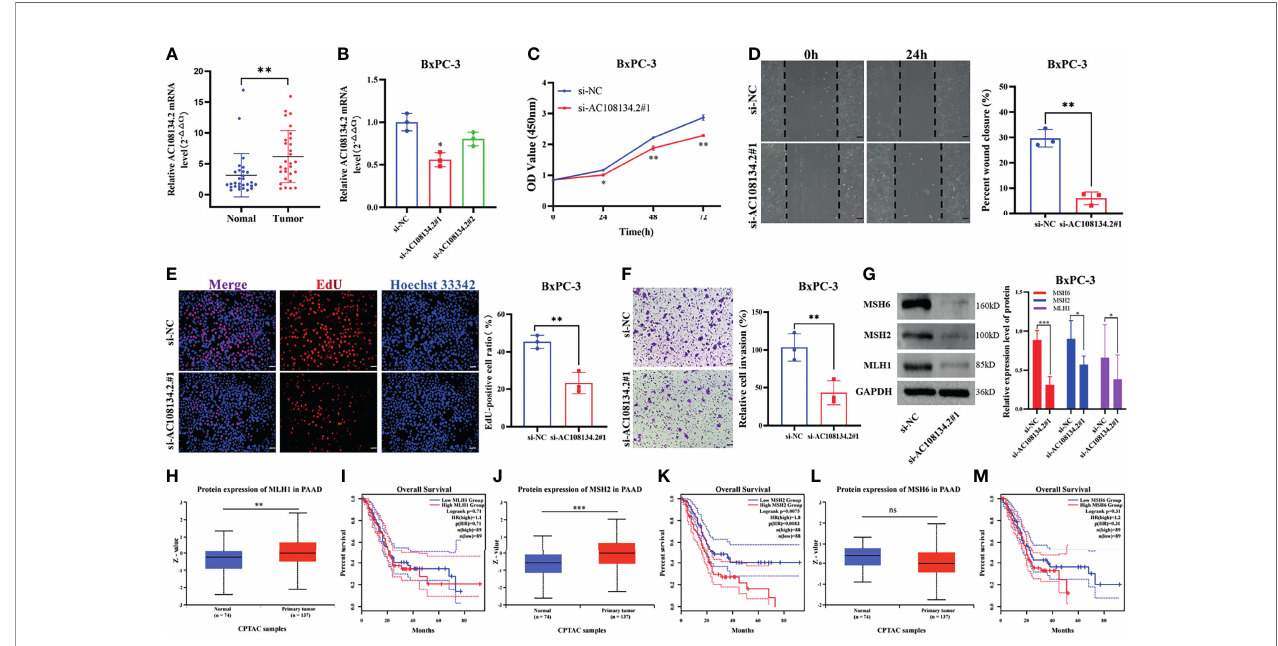
FIGURE 8 | Unfavorable impact of AC108134.2 on PAAD in vitro . (A) qRT-PCR analysis of AC108134.2 mRNA levels in PAAD tissues and corresponding adjacent tissues (n = 29). (B) The knockdown ef fi ciency of AC108134.2 expression in BxPC-3 cells was veri fi ed through qRT-PCR. (C) CCK-8 assay was used to detect the changes in cell viability of BxPC-3 cells following silencing of AC108134.2. (D) Wound healing array was used to analyze the wound healing of BxPC-3 cells downregulated by AC108134.2. (E) Changes in the proliferation rate of BxPC-3 cells after silencing of AC108134.2 were analyzed through EdU staining. (F) Transwell invasion assay was used to analyze changes in the invasive ability of BxPC-3 cells after silencing of AC108134.2 (G) Western blot analysis of the expression of genomic instability-related proteins (MLH1, MSH2, and MSH6) after knockdown of AC108134.2. The CPTAC tool was used to analyze the protein expression levels of MLH1 (H) , MSH2 (J) , and MSH6 (L) in PAAD. GEPIA2.0 server was used to analyze the overall survival rate of MLH1 (I) , MSH2 (K) , MSH6 (M) high, and low expression groups in PAAD.* p < 0.05, ** p < 0.01, *** p < 0.001. ns stands for p >